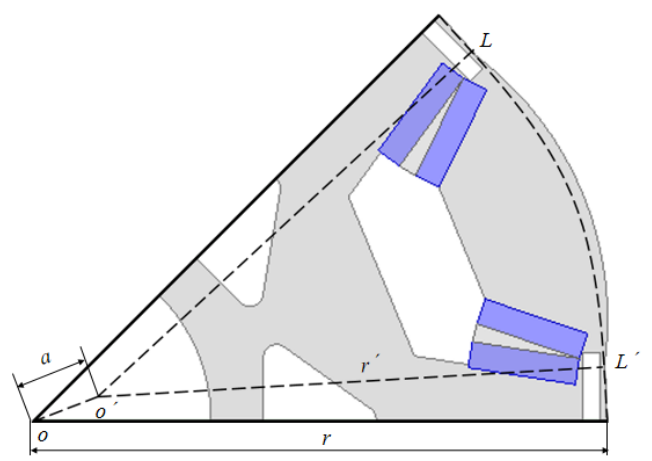
Figure 7. Rotor structure with an uneven air gap.